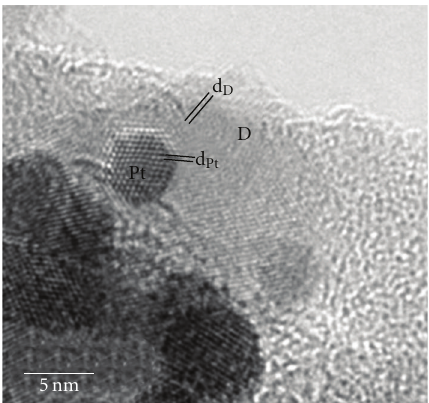
Figure 15: High-resolution TEM image of a Pt particle formed on B-UNCD-D. The Pt loading was 5% Pt/C and the metal at layer was formed by a chemical impregnation method. P is the platinum particle, D is the diamond, and d Pt and d D are the lattice spacing for Pt and diamond (Reprinted with permission from [63]).